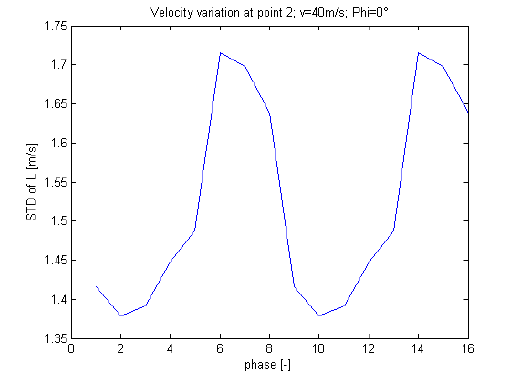
Fig. 12a, b. Phase-locked measurement – mean-phase velocity and STD value - at point 2.